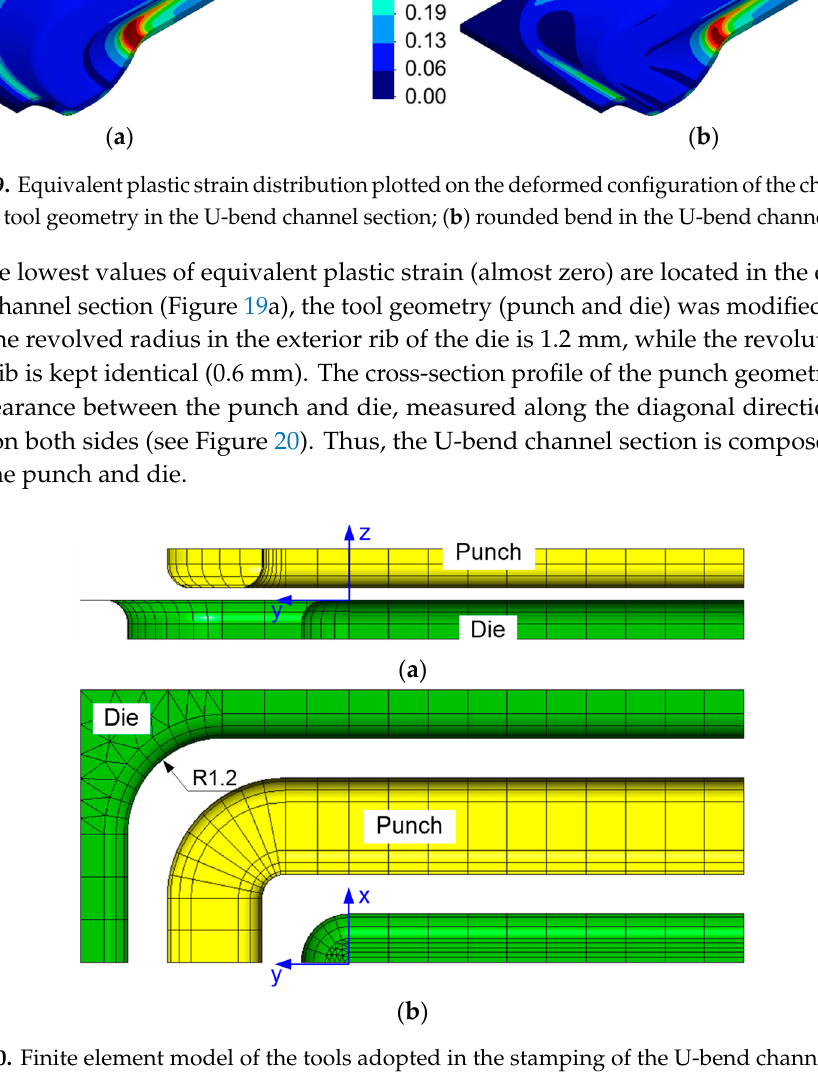
Figure 20. Finite element model of the tools adopted in the stamping of the U-bend channel section (rounded bend): ( a ) lateral view; ( b ) top view.